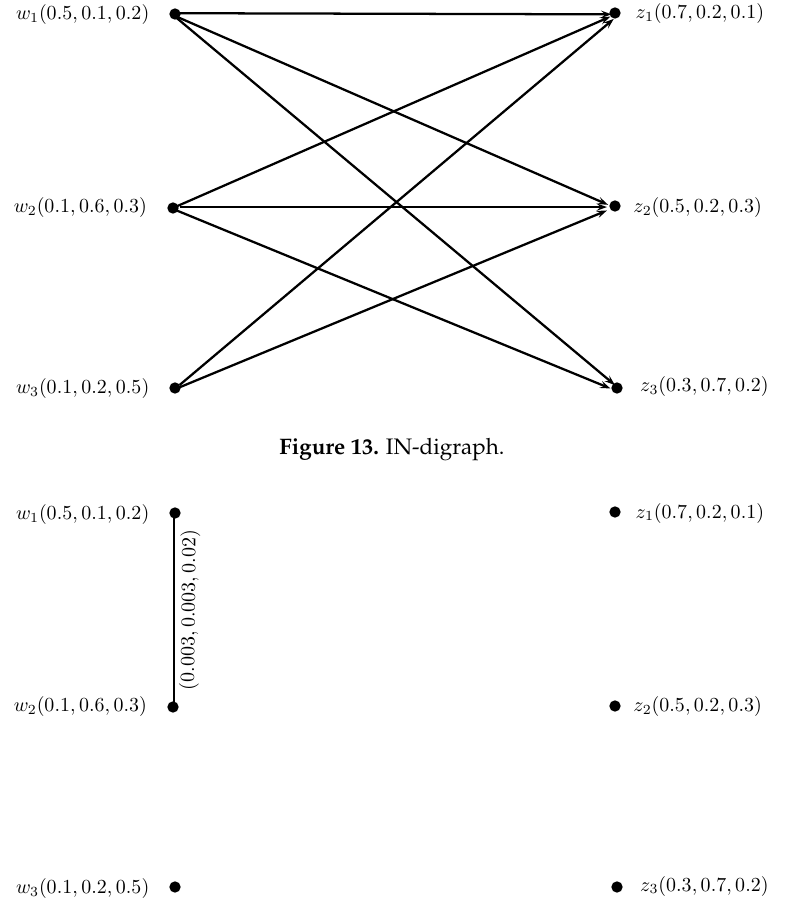
Figure 13. IN-digraph.